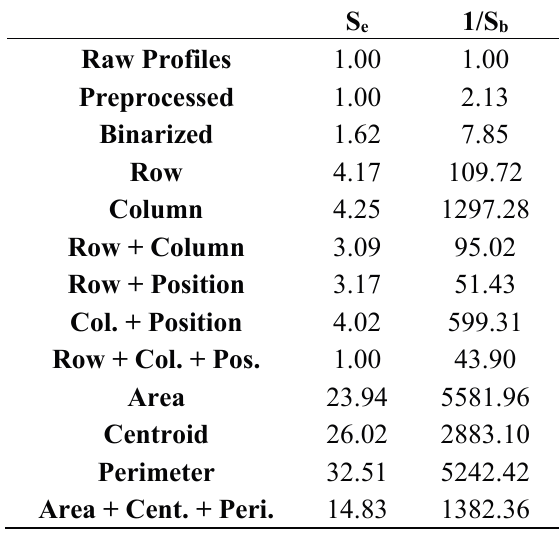
Table 12. Classification error and computational burden sensitivities.